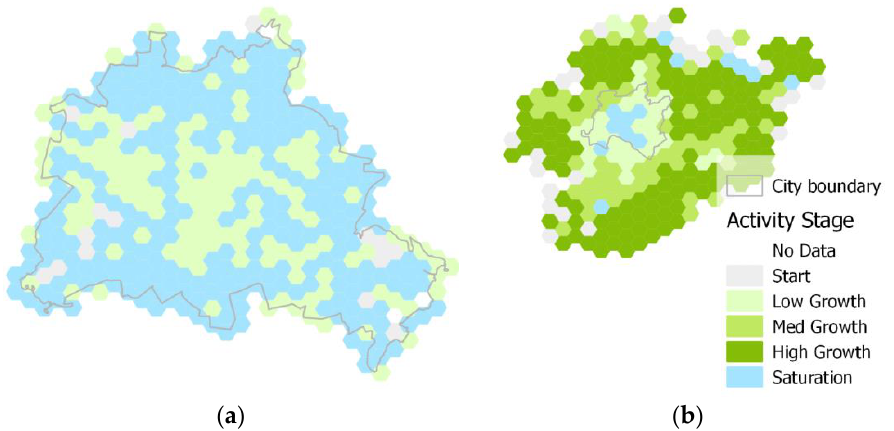
Figure 9. Activity stages for the feature type street by the end of 2015 (extrapolated) for ( a ) Berlin and ( b ) Kathmandu.